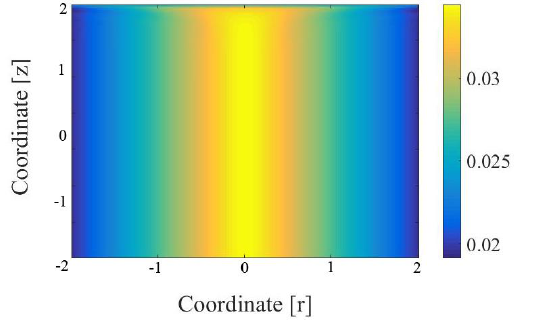
Fig. 2. The temperature increase in the sample caused by exposure to THz